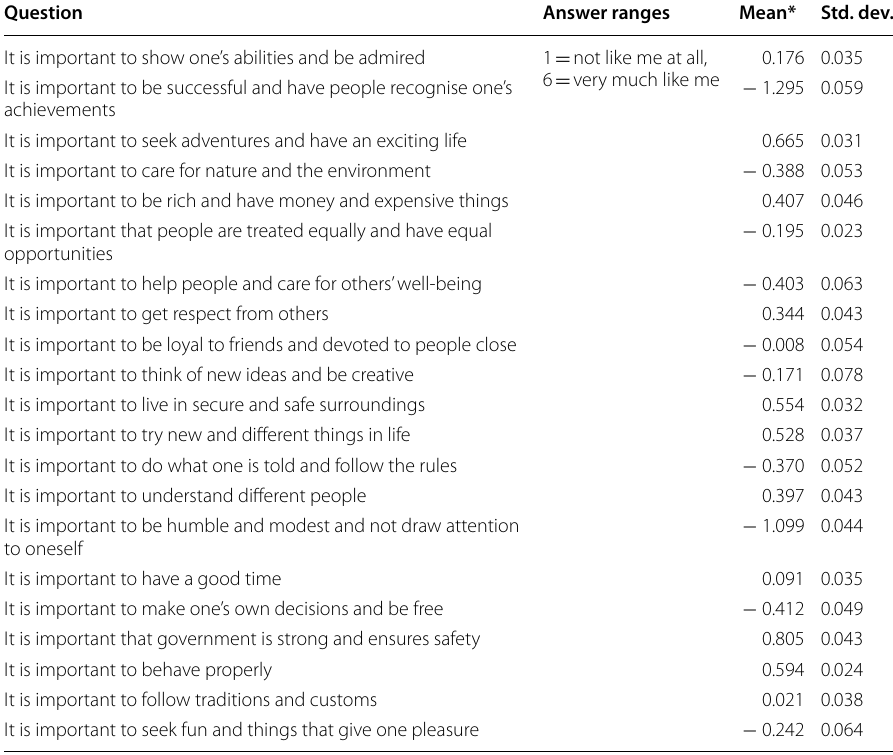
*Post-stratification weights are used. Population size N